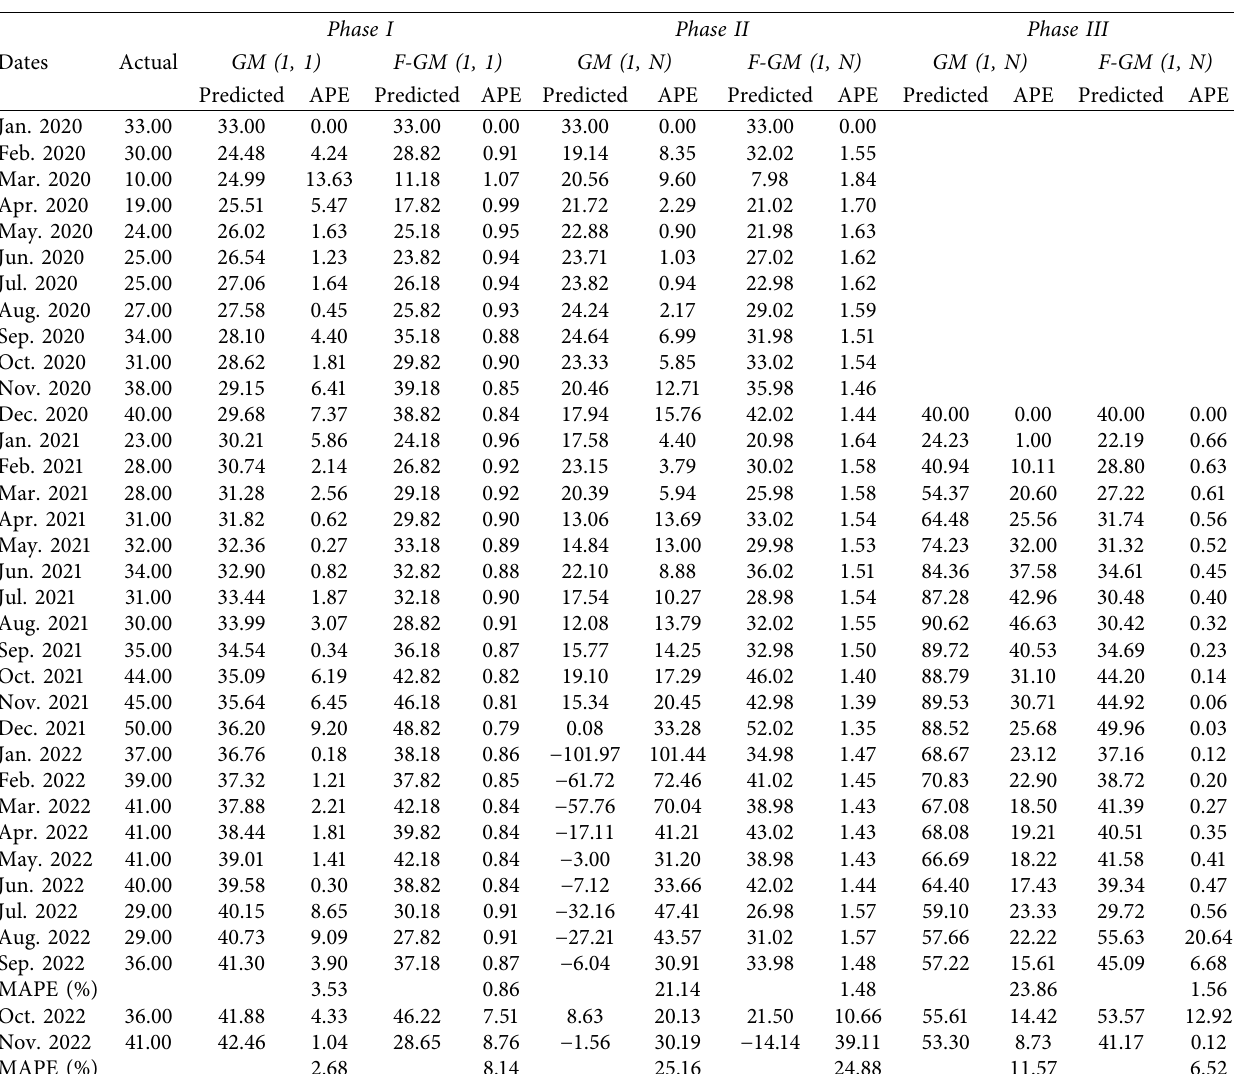
Table 2: Forecasting results of the competing models for global travel sentiment.